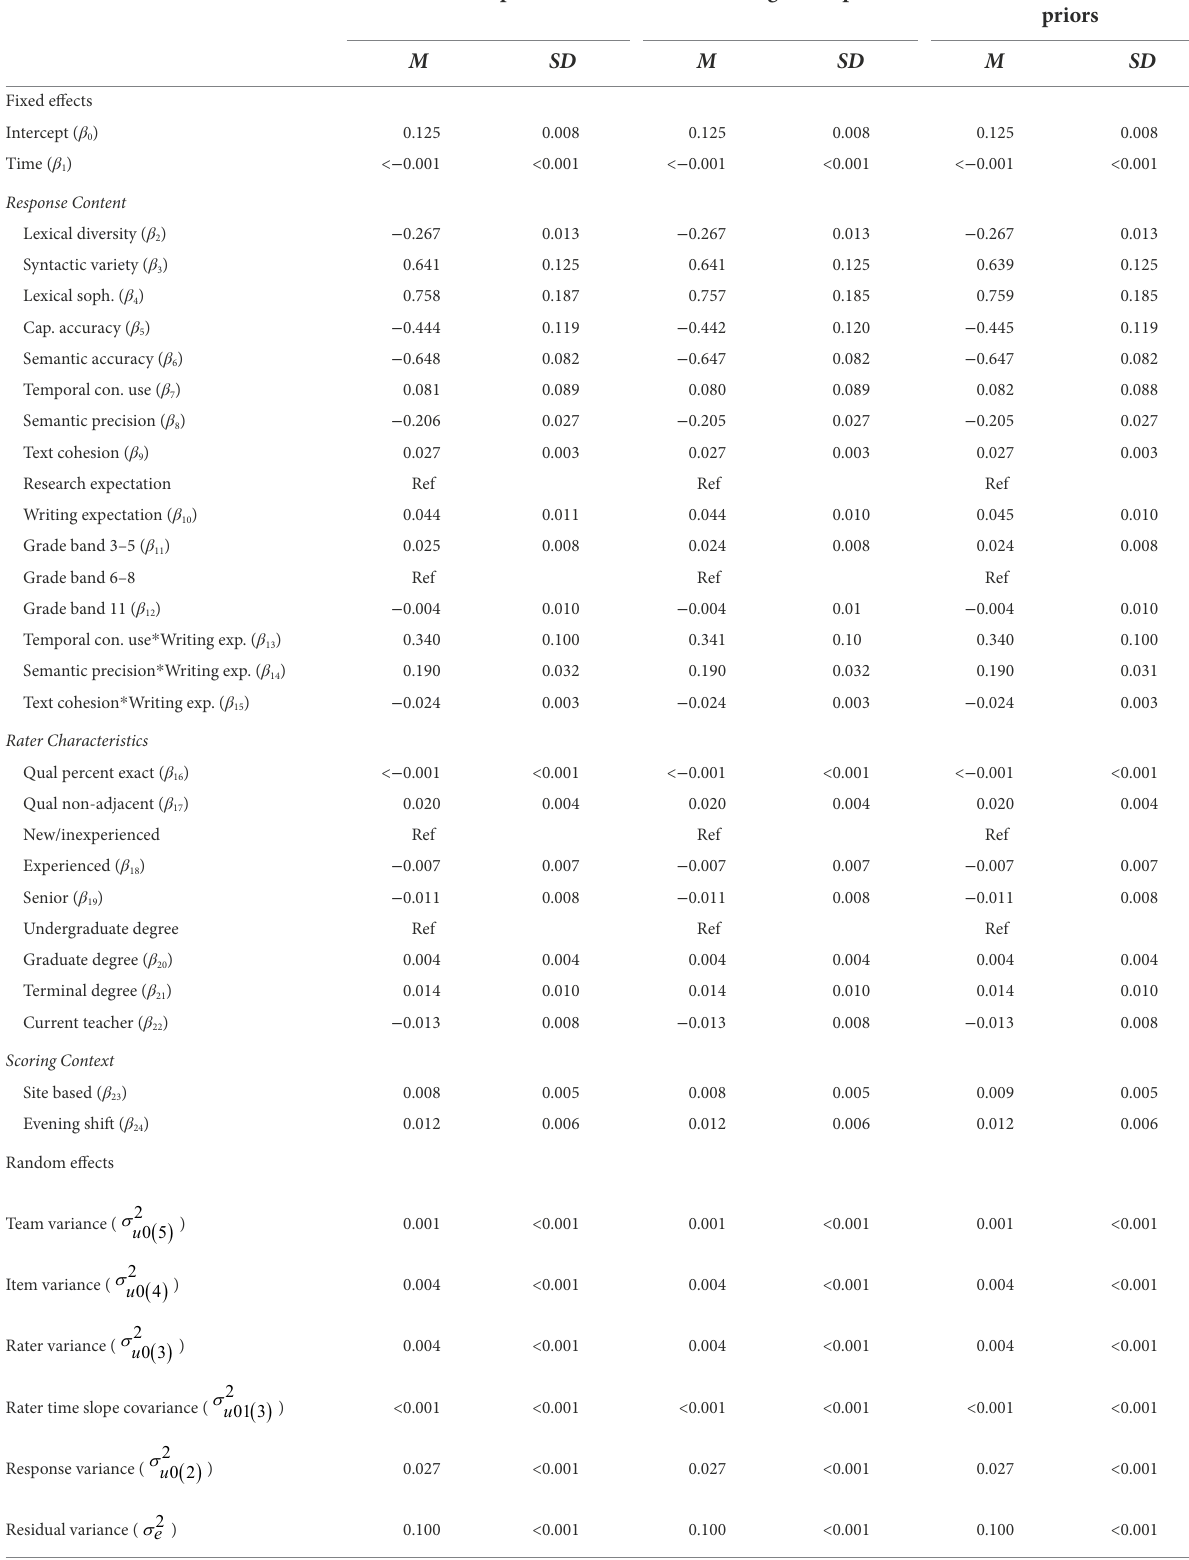
TABLE 6 Effects of alternate prior specification on parameter estimates for model